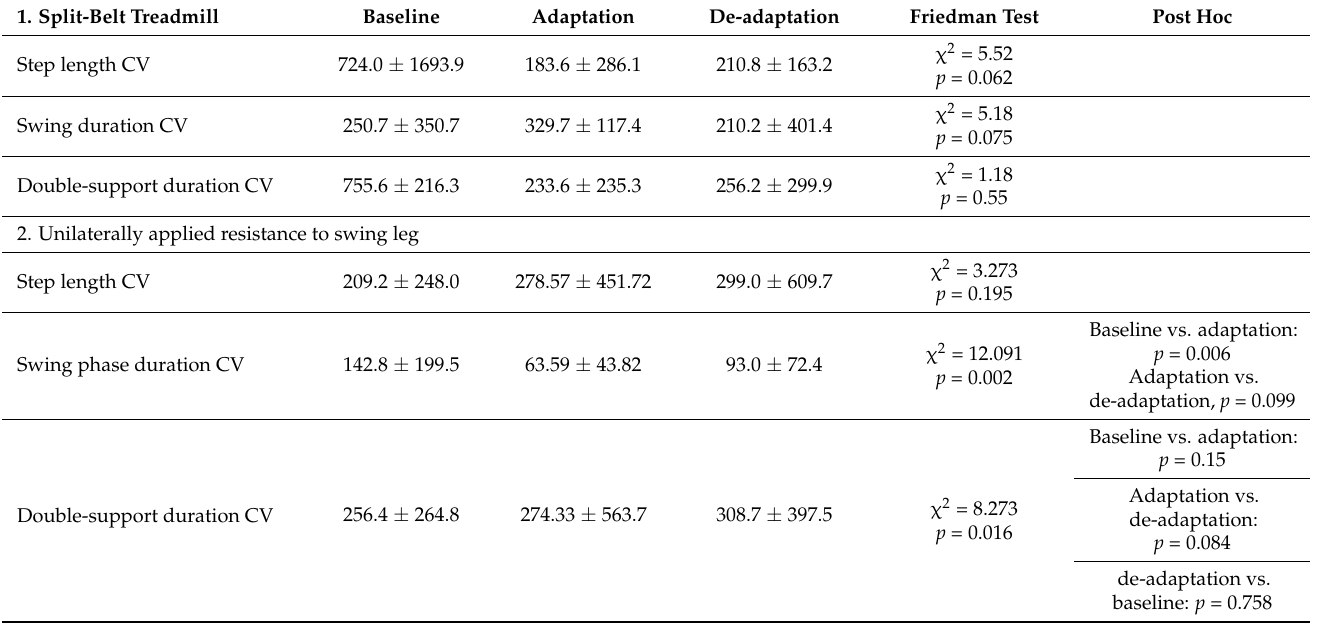
Table 2. Gait variability (coefficient of variance, CV) during (1) split-belt treadmill walking, and (2) unilaterally applied resistance to swing leg, using the Friedman test through testing periods. Values are presented as mean ± SD.